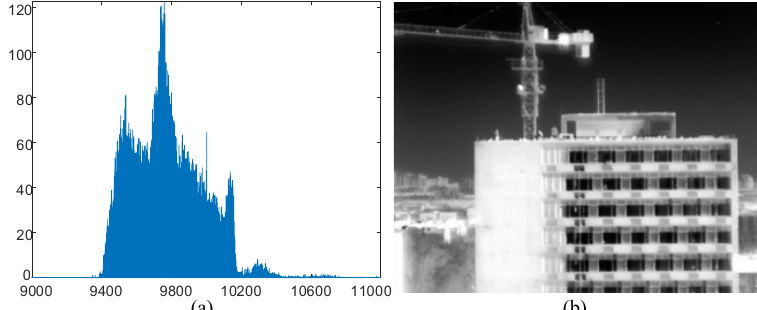
Figure 4. The enhanced result of the given infrared image. ( a ) The neighborhood conditional histogram of the given infrared image. ( b ) The corresponding enhanced result based on the neighborhood conditional histogram. The X-axis range in (a) is set to be (9000,11,000) for better visualization.